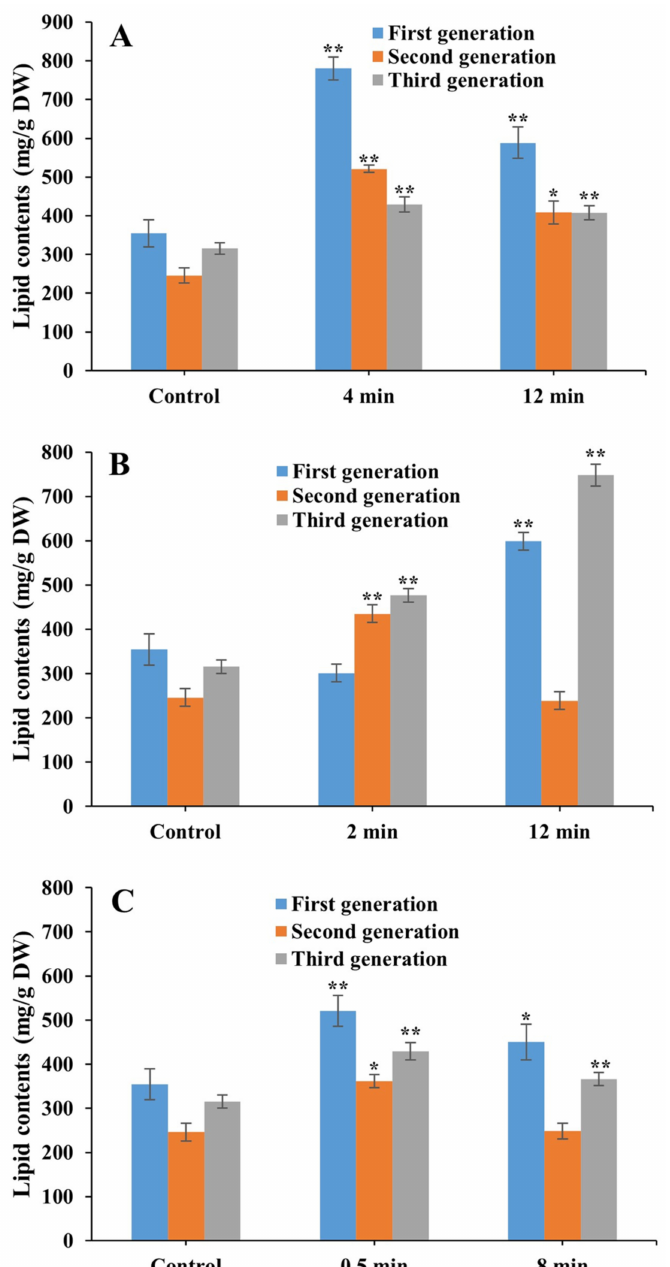
Figure 7. Lipid contents of laser mutants of Chlorella pyrenoidesa strain FACHB 31 treated with He–Ne ( A ), Nd:YAG ( B ), and SC ( C ) cultured under heterotrophic cultivation for 21 days (three generations). Data are presented as mean ± standard errors ( n = 3). Symbols “*” and “**” indicate statistically significant differences compared to controls at p < 0.05 and p < 0.01,